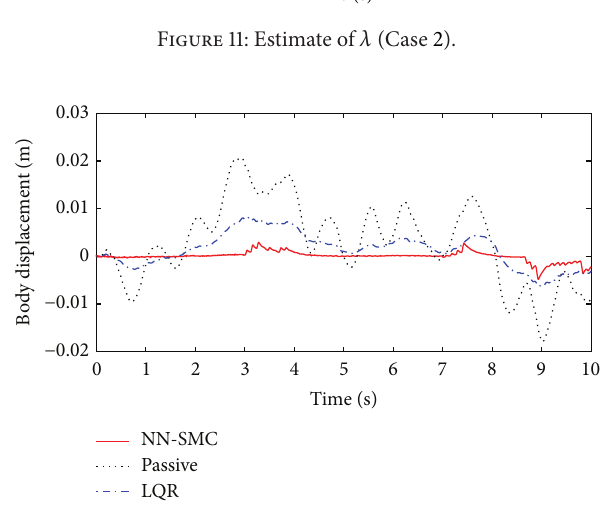
Figure 12: Body displacement (Case 3).